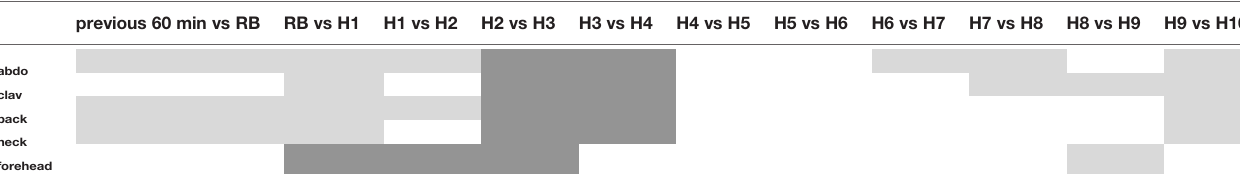
TABLE 2 | Comparisons of each local proximal skin temperature (T abdo , T clav , T back , T neck , T forehead ) from 1 h to the next one.